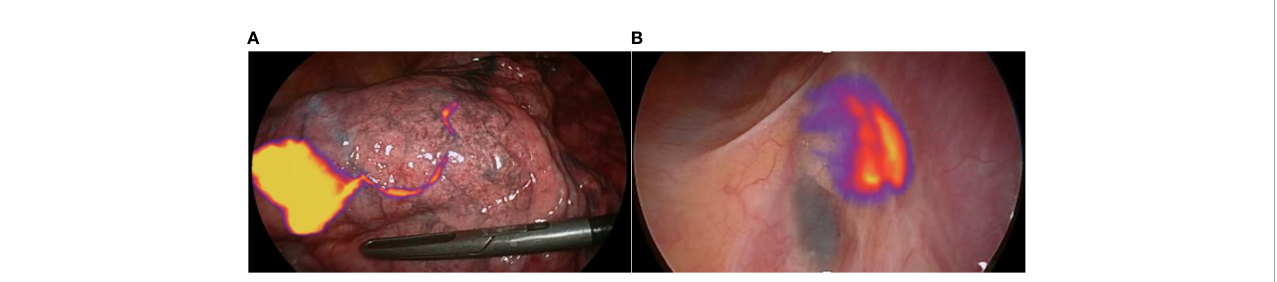
FIGURE 1 NIR-Guided sentinel lymph node speci fi city: (A) The lymphatic pathway is clearly seen with NIR on the surface of the lung, starting from the lung nodule located in the right lower lobe here. (B) The intraoperative view shows fi xation at station 7. Only one of the two lymph nodes is intensely fi xed with the NIR-camera in “ Tumor ” mode: this is the sentinel lymph node.